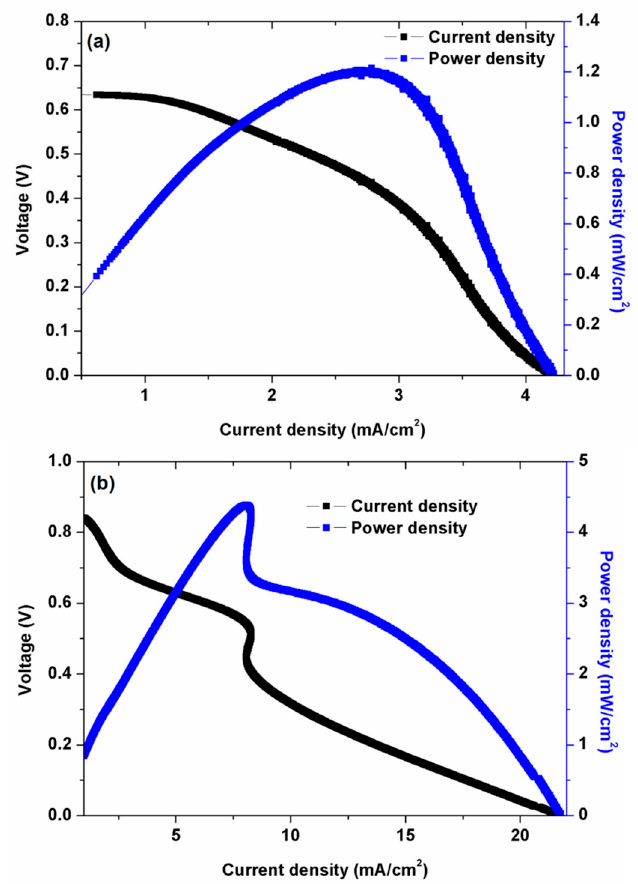
Figure 7. Urea/O 2 test results for ( a ) QPSf/DBB and ( b ) QPSfDMC2 at 70 ◦ C. The anolyte was 0.33 mol/L urea + 1 mol/L of KOH, while humidified O 2 was used as the catholyte.